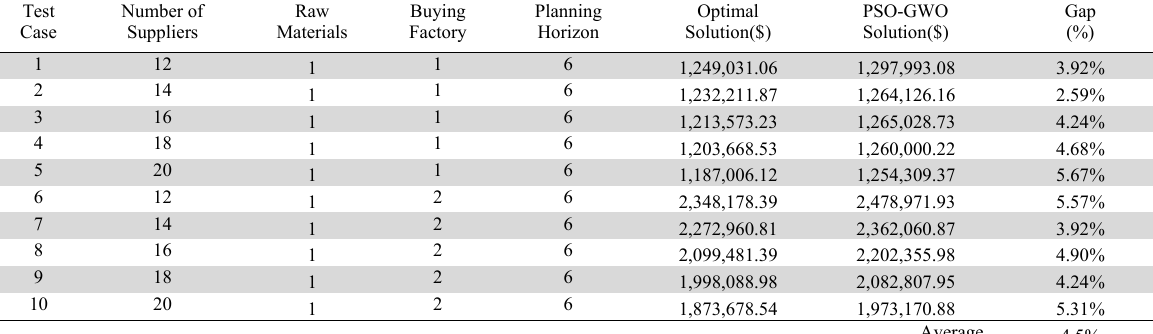
Comparison Results for Small Sized Problems